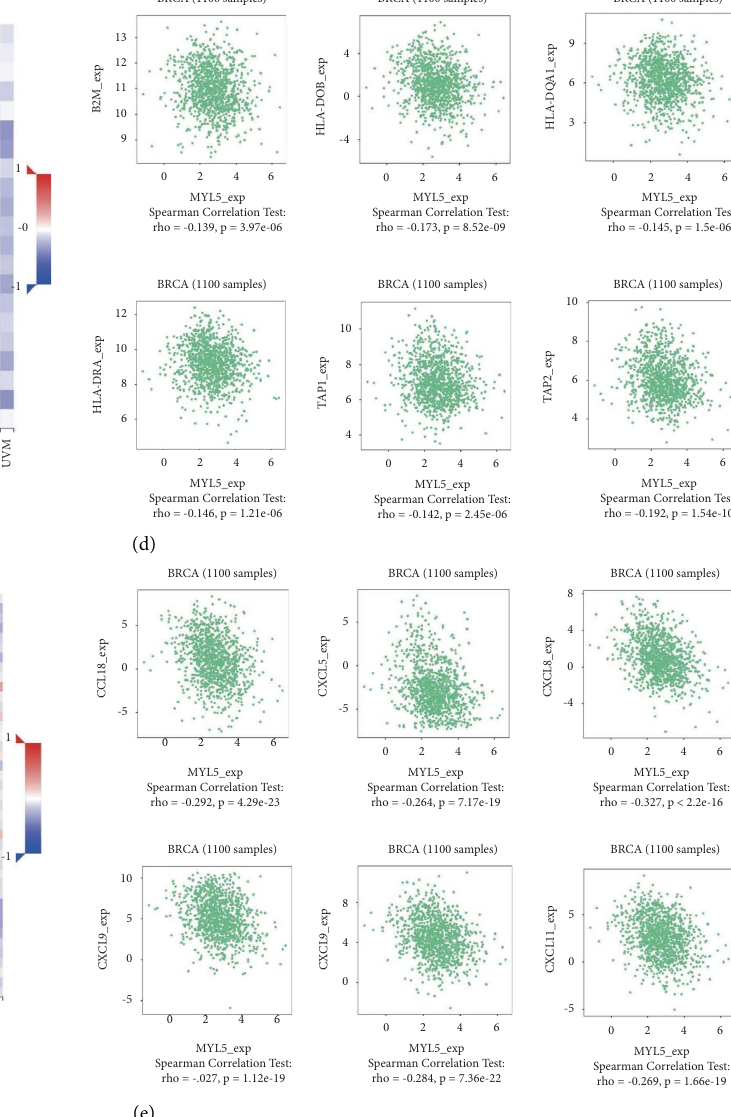
Spearman Correlation Test: rho = -0.269, p =